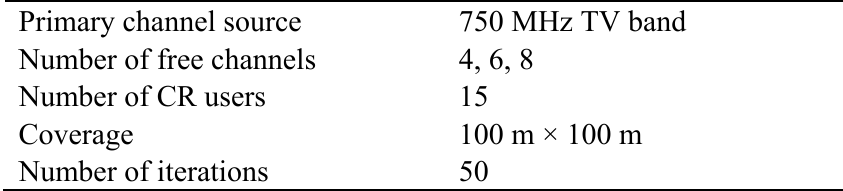
Table 1. Simulative